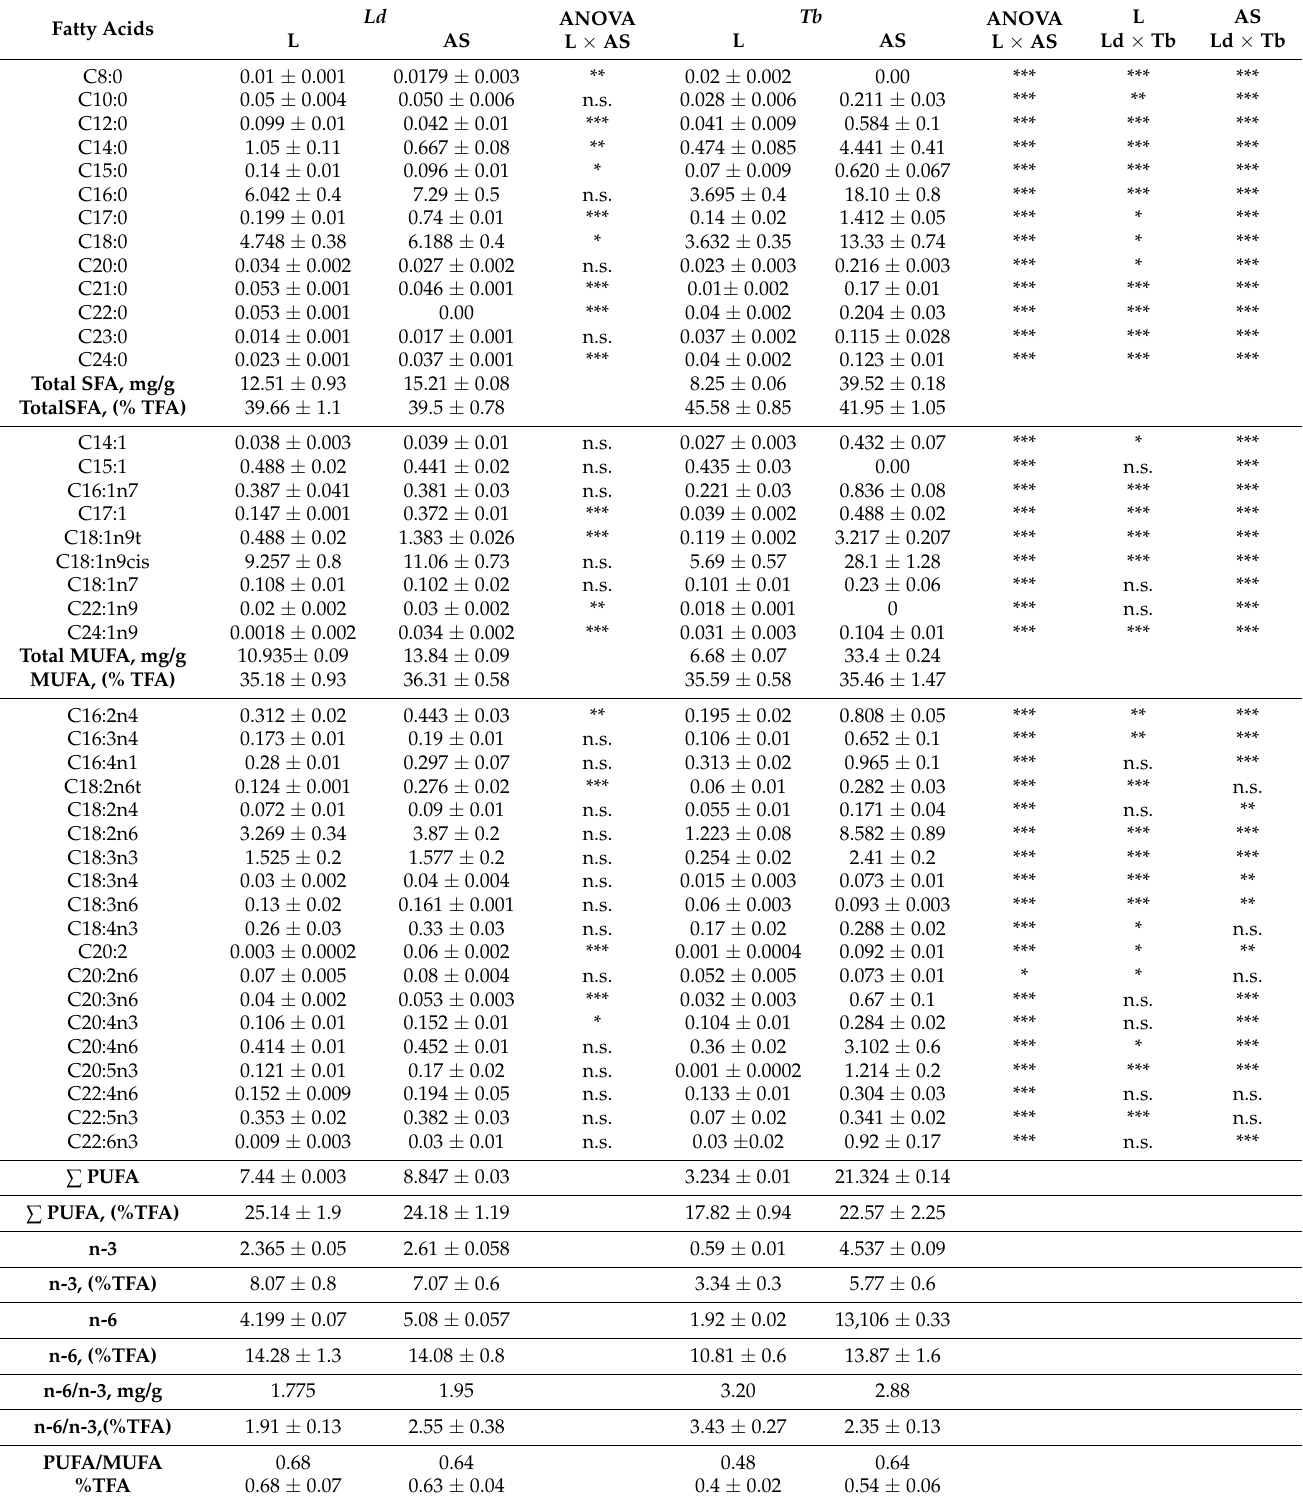
Table 2. Fatty acid contents (mg/g TDM) of the Longissimus dorsi and Triceps brachii muscles from different age